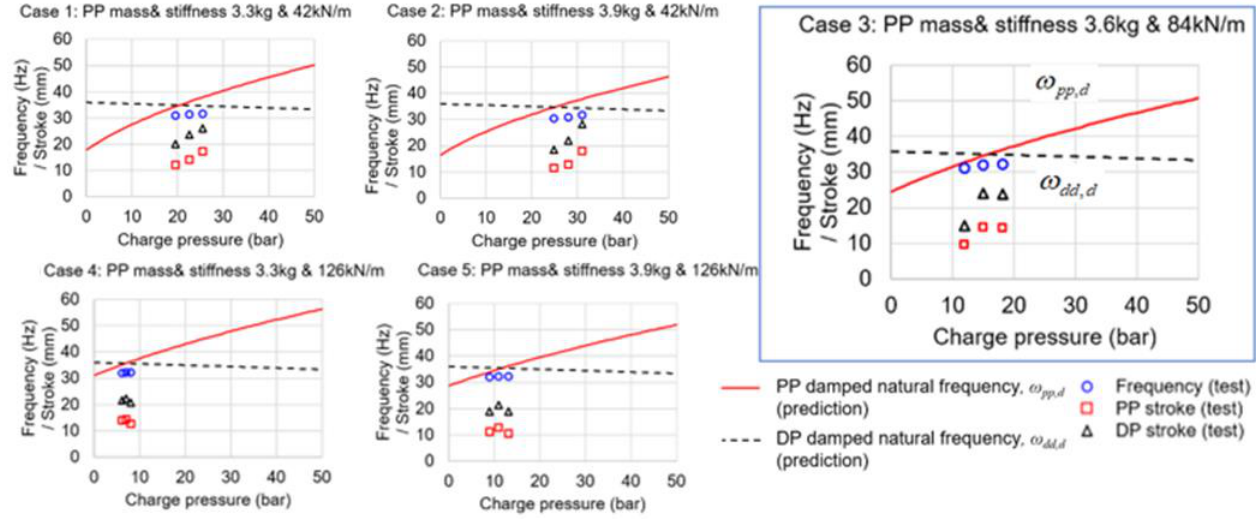
Figure 9. Comparison of experimental and the simple vibration analysis results for cases 1–5. Predicted PP and DP damped natural frequencies with increasing charge pressure of 0–50 bar (prediction) and the operable pressure ranges, the frequency, and the two piston strokes (experiment) are given.